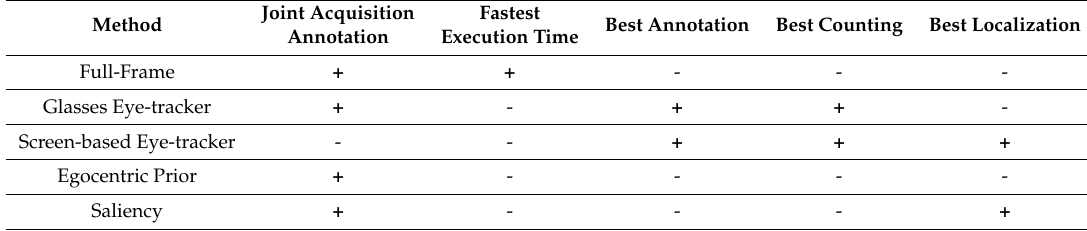
Figure 8. Qualitative assessment of results. From left to right, an example of the attention area captured by eye-tracking, automatic annotation obtained from the proposed image processing pipeline of Figure 3, ground-truth manually recorded, and comparison of manual ground-truth and automatic segmentation. ( a ) Examples of good performance; ( b ) Some challenging conditions wherein more errors were found (missed detection, false detection). Table 2. Qualitative summary of the five uses of egocentric devices compared in this